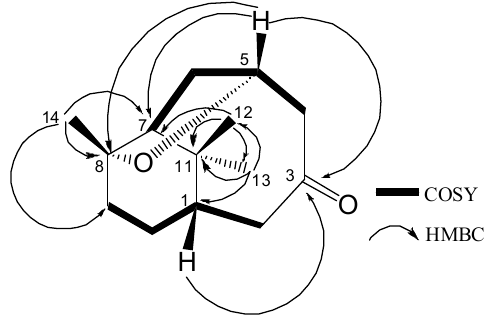
Figure 2. Key HMBC and 1 H- 1 H COSY correlations of 1.